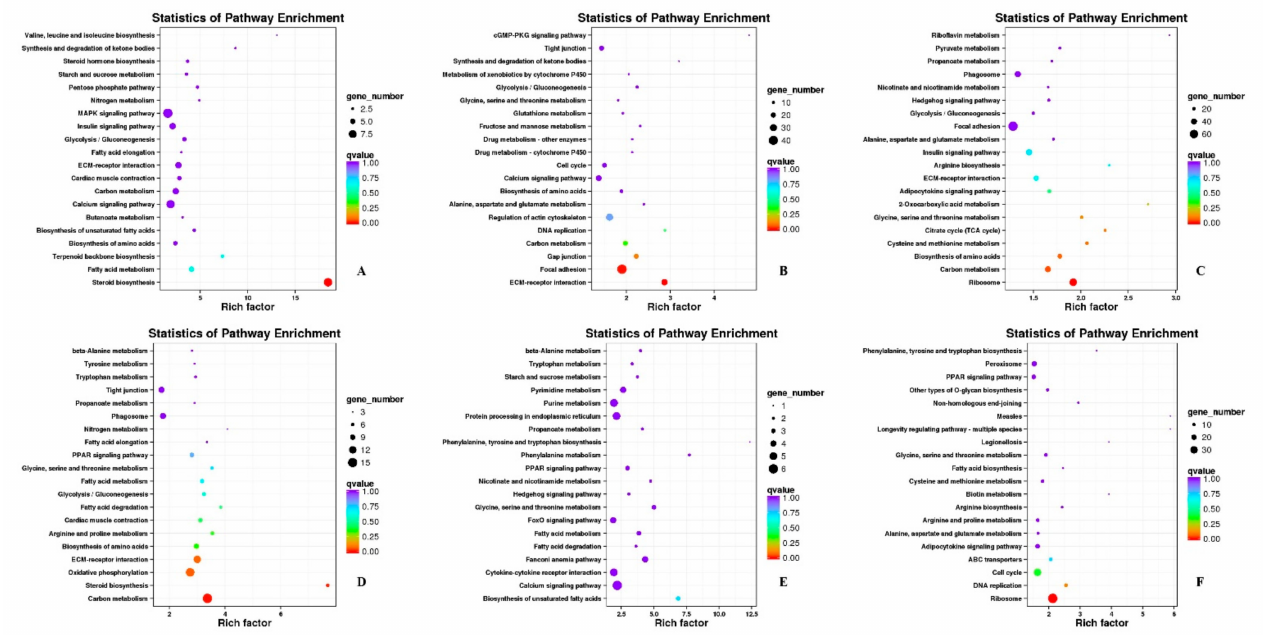
Figure 6. KEGG annotation of DEGs in Pekin duck. ( A ) PE17B_vs_PE21B; ( B ) PE21B_vs_PE27B; ( C ) PE27B_vs_PM6B; ( D ) PE17L_vs_PE21L; ( E ) PE21L_vs_PE27L; ( F ) PE27L_vs_PM6L. Note: Each circle represented a KEGG pathway, the name of which was shown on the left legend. Abscissa indicated enrichment factors, showing the proportion of (a) to (b), (a) was the ratio of differentially expressed genes in the pathway with all DEGs in all pathways, (b) was the ratio of genes in the pathway with all genes in all pathways. The bigger the Rich factor is, the more significant the pathway is. The color of circle represented q value which is adjusted p value by multiple hypothesis testing. Thus, the smaller the q value is, the more significant the pathway is; the circle size represented the number of differentially expressed genes annotated with the pathway, the bigger circle size is, the higher number of genes